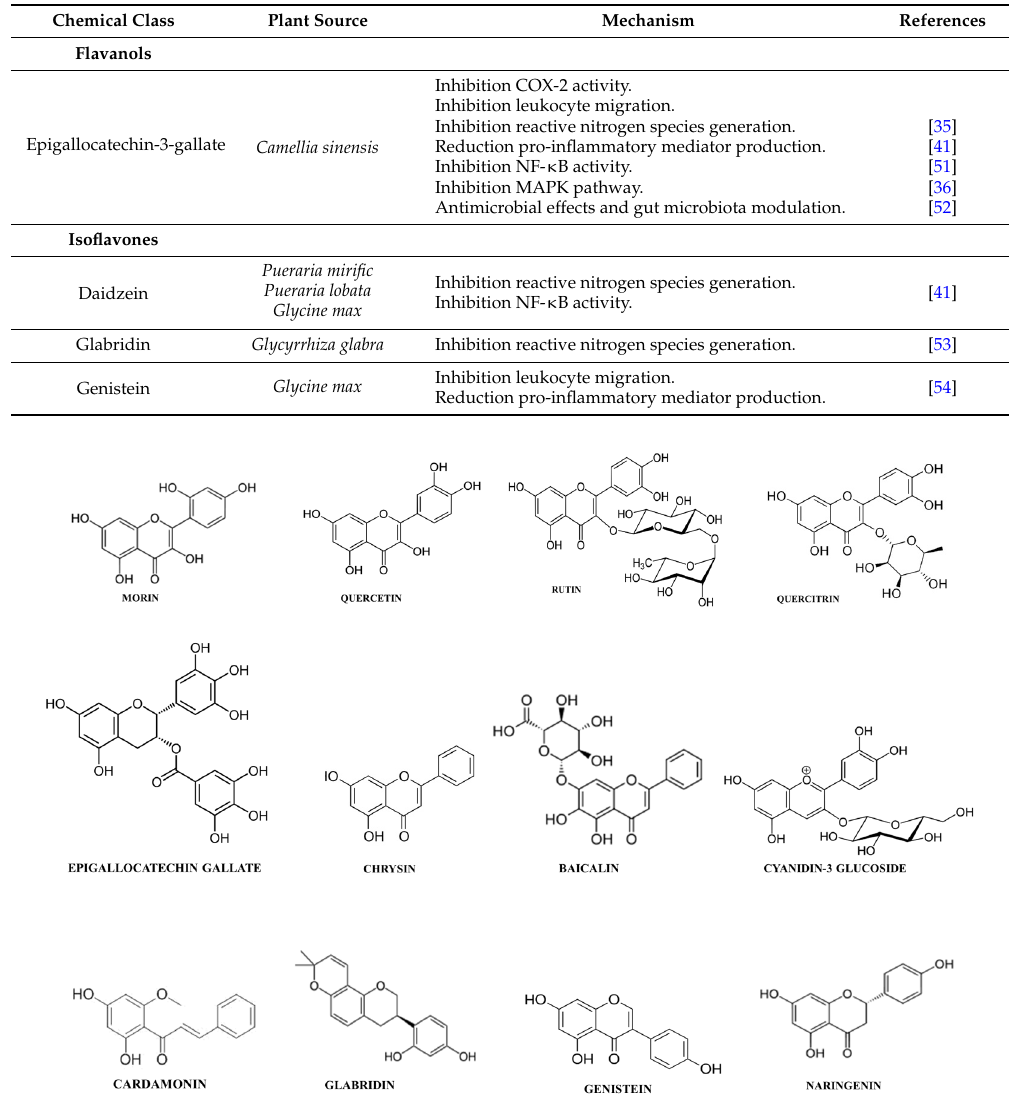
Figure 2. Chemical structures of the main flavonoids with intestinal anti ‐ inflammatory properties.